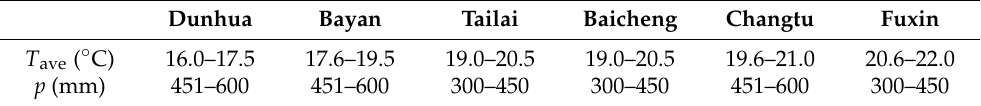
Figure 2. Total precipitation ( a ) and average temperature ( b ) during maize growing season from 1981 to 2018 for the Dunhua, Bayan, Tailai, Baicheng, Chuangtu and Fuxin stations. Table 2. The climatic regions classified by average temperature ( T ave ) and total precipitation ( p ) during the maize growing season from 1981 to 2018 in Northeast